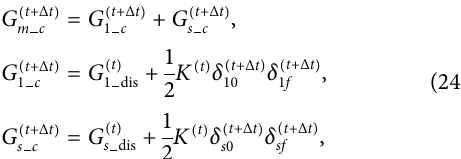
Frontiers in Materials |